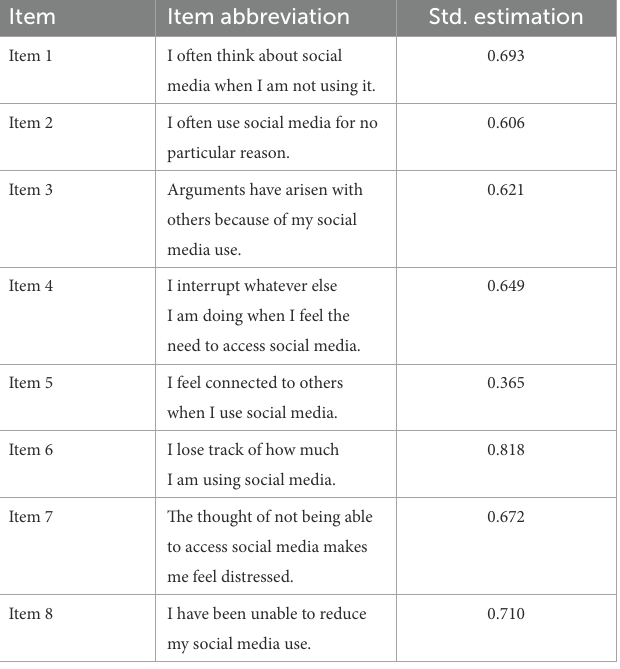
TABLE 1 Standardized loadings of the SMIQ items ( n = 374).